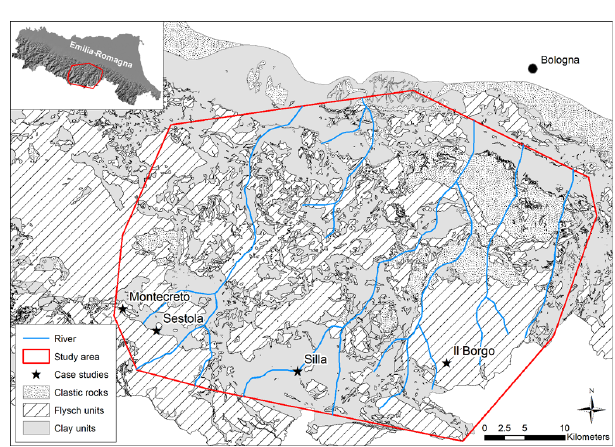
Fig. 6. Schematic geological map of the study area.